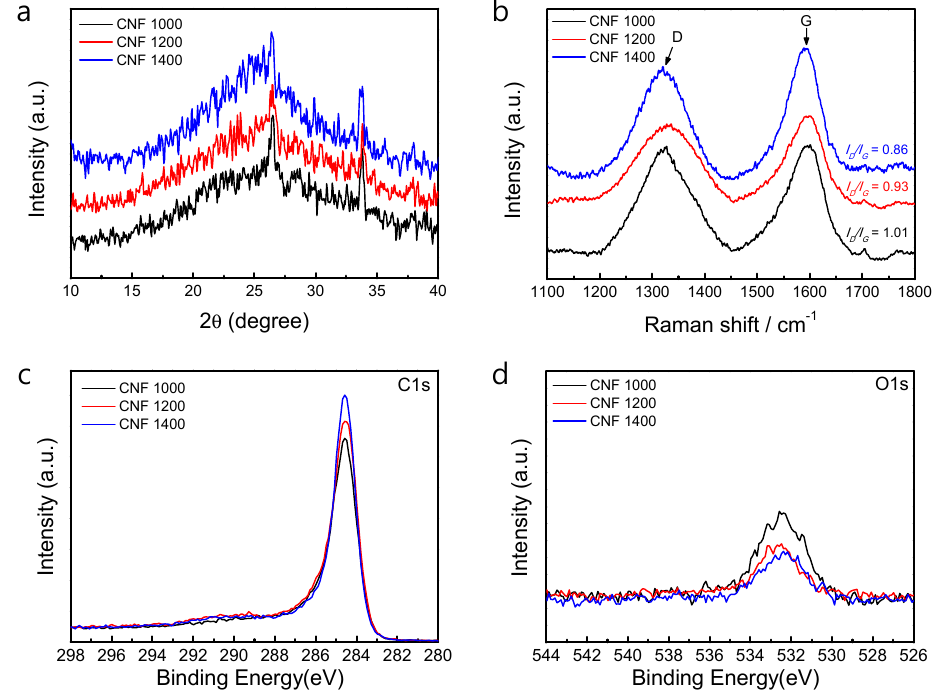
Figure 2. Analysis of CNF 1000, 1200 and 1400 of ( a ) XRD patterns, ( b ) Raman results, XPS analysis ( c ) C1s and ( d ) O1s.